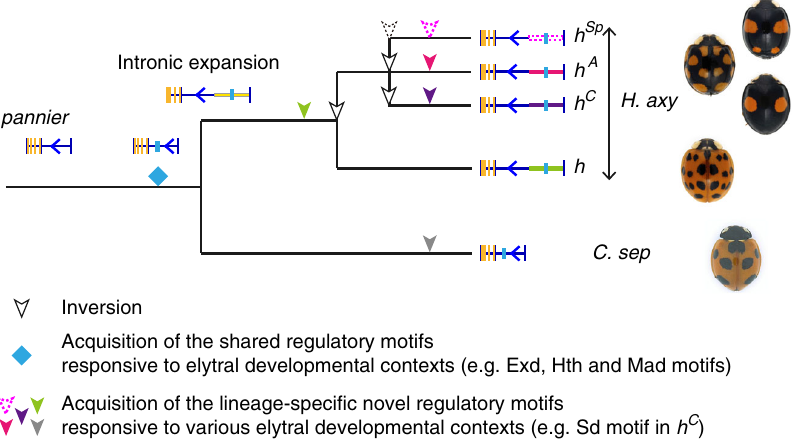
Fig. 6 An evolutionary model for the colour pattern diversi fi cation in H. axyridis . See details in the Discussion. The images of ladybird beetles are adapted from Figs. 1b and